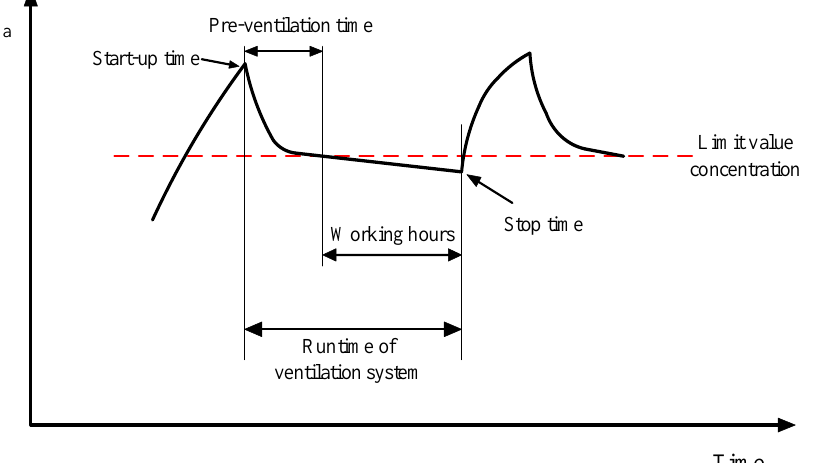
Figure 1. Schematic of VOC concentration variations in the office room under intermittent ventila- tion.